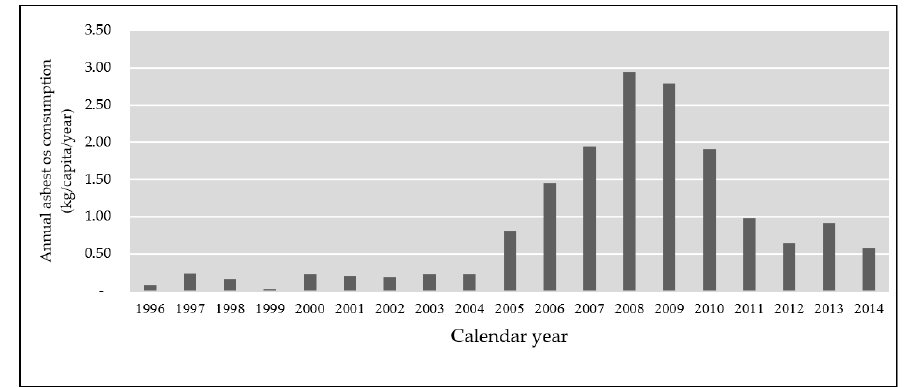
Figure 1. Annual per capita asbestos use (kg/capita/year) in Mongolia between 1996 and 2014.